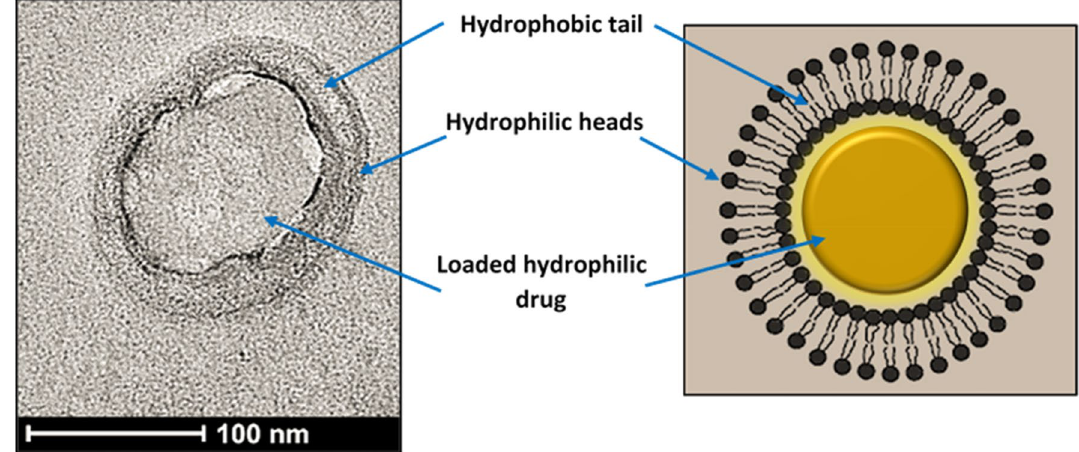
Figure 5. Transmission electron microscopy (TEM) images of calcein-loaded Tf-PEG liposomes at 100 nm scale and an illustration of the liposomes loaded with a hydrophilic drug.